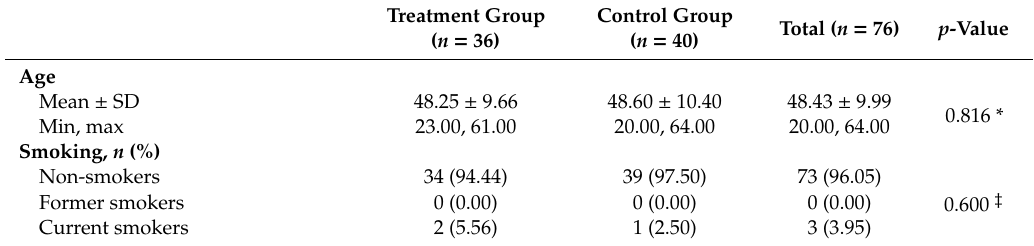
Figure 1. Overall flow diagram of the clinical study. FA, full analysis; PP, per-protocol. Table 1. Baseline characteristics of subjects participating in this study.